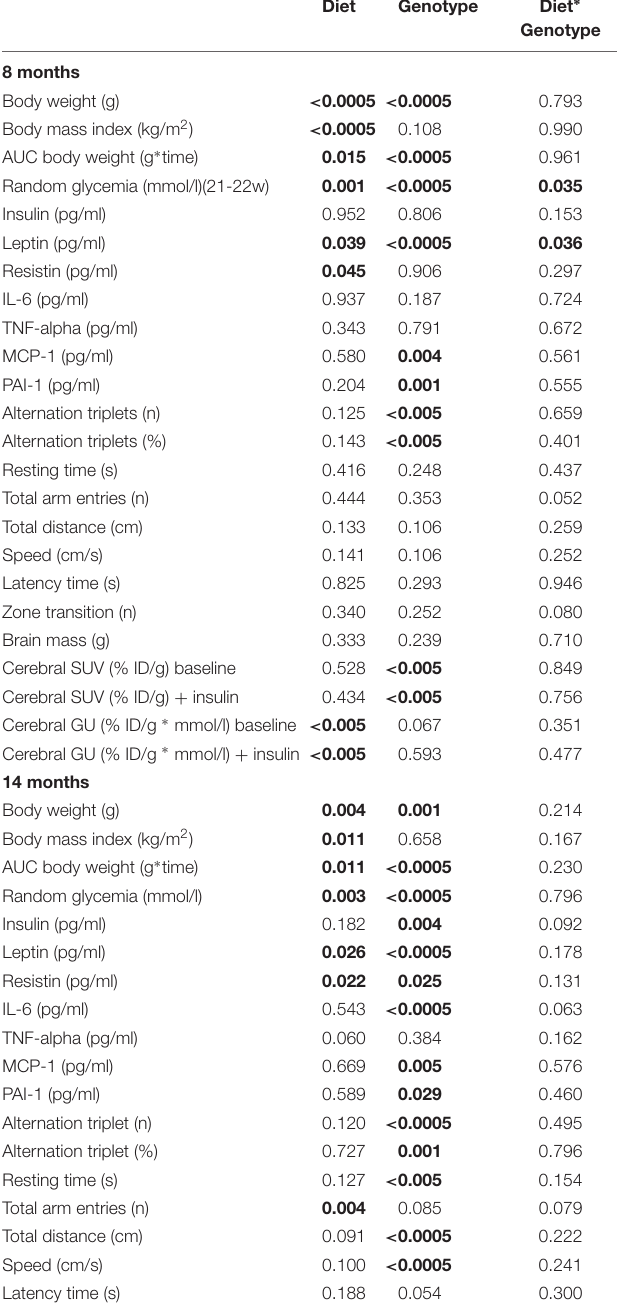
TABLE 2 | Two-way ANOVA for the effects of diet and genotype in group comparisons.